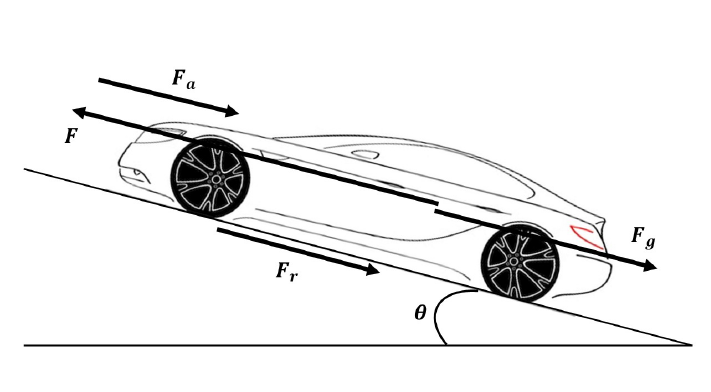
Figure 1. Longitudinal forces on the